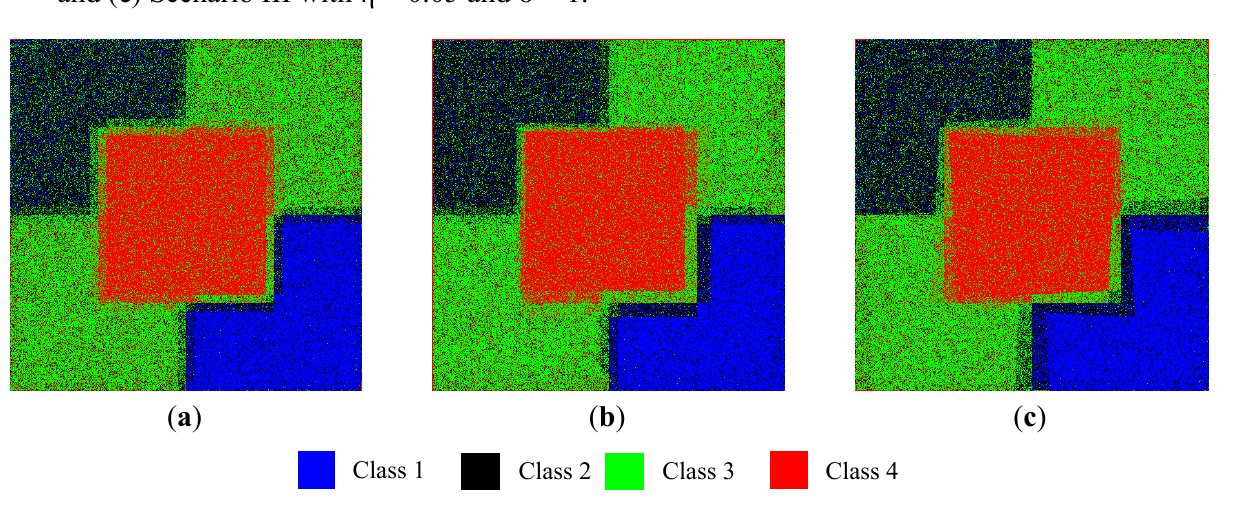
Figure 6. Examples of the maximum likelihood classifier (MLC)-based land cover maps (LCMs) for ( a ) Scenario I with δ = 12 and σ = 1; ( b ) Scenario II with ρ = 0.05 and σ = 1; and ( c ) Scenario III with η = 0.05 and σ =